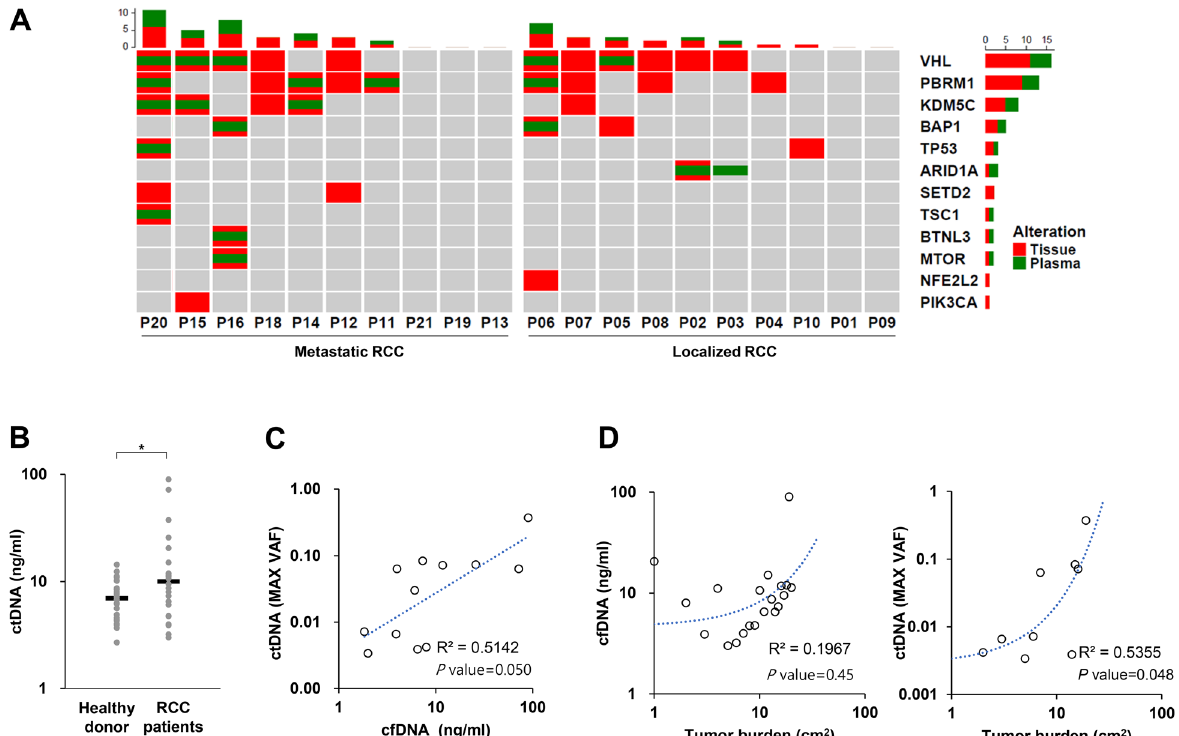
Figure 2. Mutation profiling of tissue and/or plasma samples from patients with renal cell carcinoma (RCC) ( A ) OncoPrint chart shows the occurrence of mutations as profiled by targeted ultra-deep sequencing techniques across 20 patients with RCC. Concordance of variants detected in plasma cell-free DNA (cfDNA) samples compared with biopsy-based sequencing tests is shown in the chart. Each patient sample is indicated as a grey box with mutations indicated in green (plasma) and red (tumor tissue). The barplot is represented as stacked, that show numbers of different varients for each sample and for each gene. ( B ) Distribution of baseline cfDNA levels in patients with RCC and healthy donors. * p value < 0.05. ( c ) The association between the levels of cfDNA and circulating tumor DNA (ctDNA). ( d ) The association between tumor volume and the levels of cfDNA or